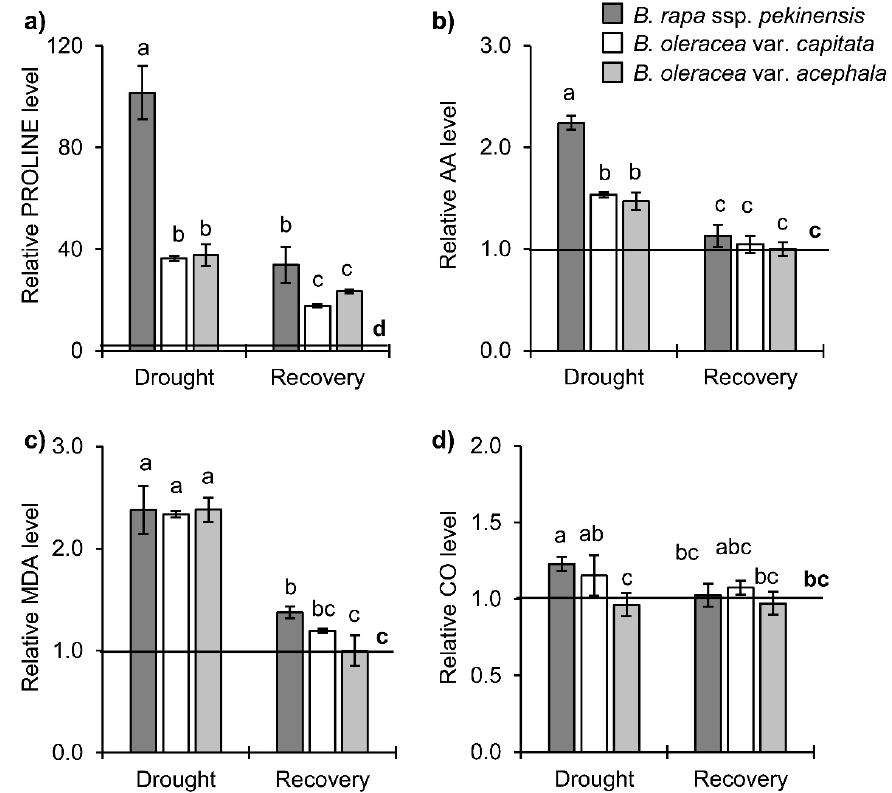
Figure 3. The contents of ( a ) proline, ( b ) ascorbic acid (AA), ( c ) malondialdehyde (MDA) and ( d ) reactive carbonyl groups (CO) in the cabbage leaves after the drought period (at the point when the RWC was 40–50%) and 24 h after re-watering. Controls are normalized to the value 1. Columns marked with different letters are statistically significantly different ( p ≤ 0.05). The bars represent mean ± SD, n = 4. Raw data are presented in Supplementary Table S2.